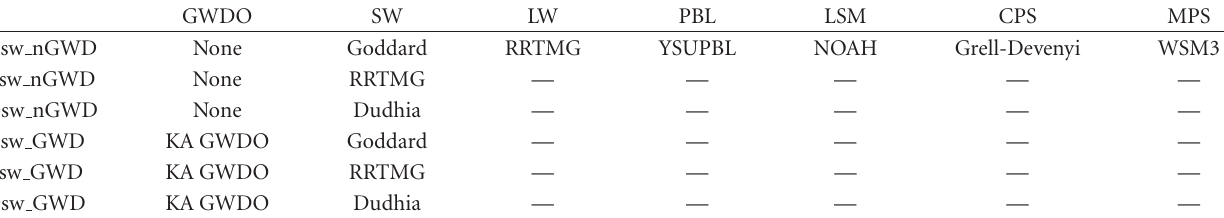
Table 1: A summary of the physics options used in the numerical experiments. “—” denotes the same option as that in the Gsw nGWD experiment.